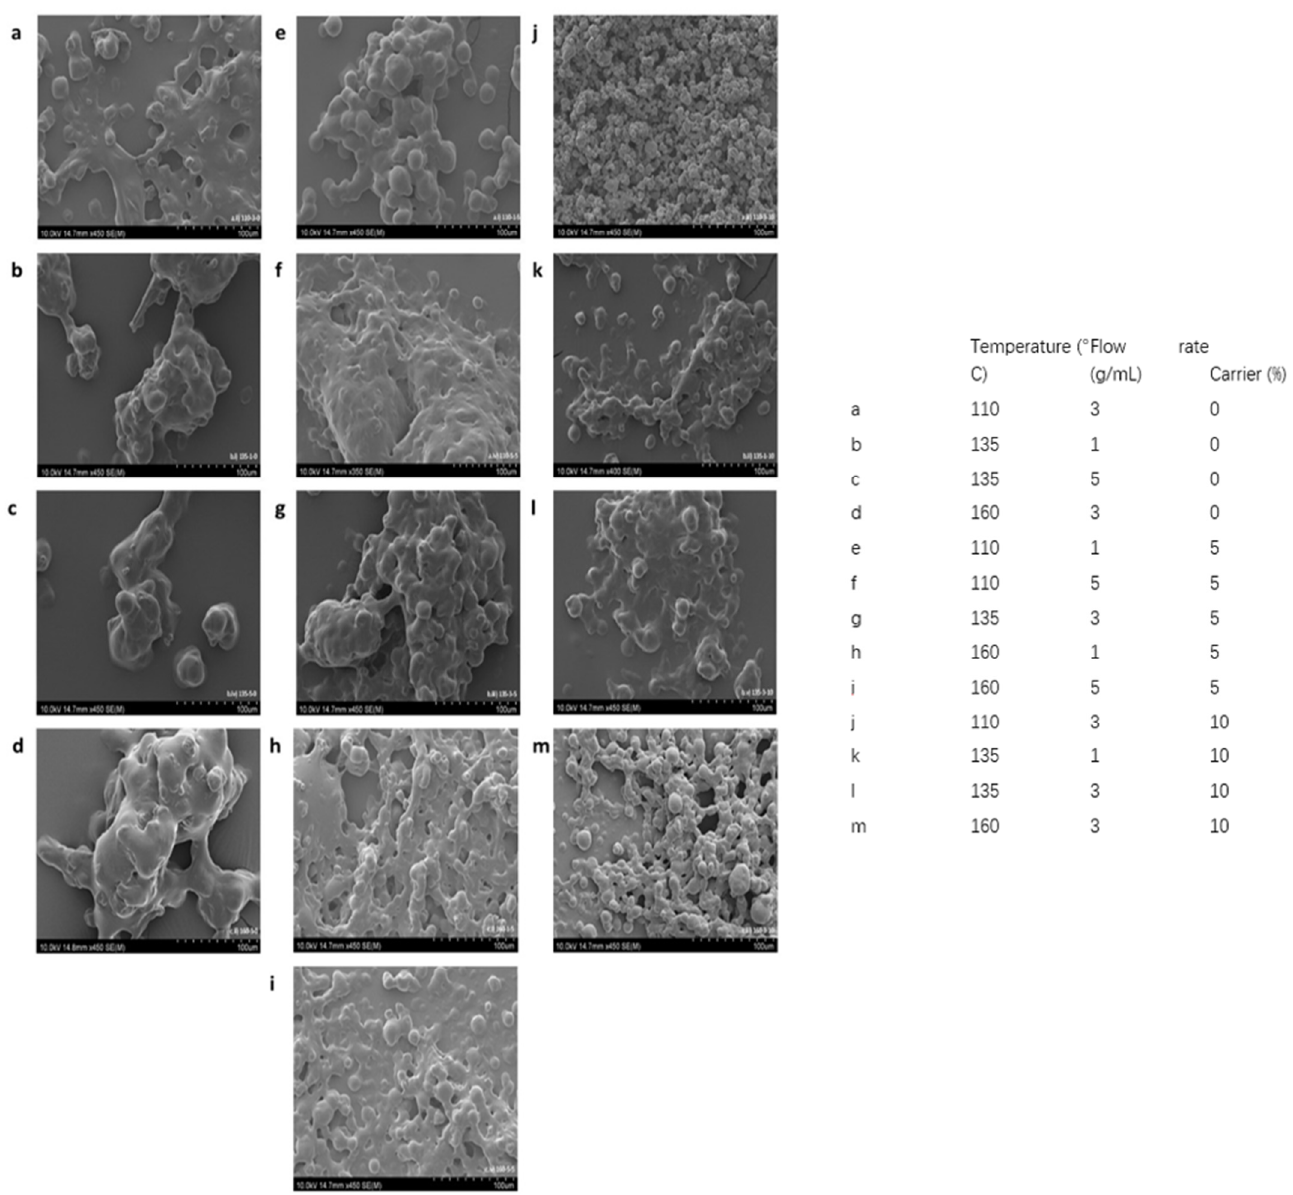
Figure 1. The microstructure of Tamarillo powder under different spray-drying conditions (temper- ature, flowrate, and carrier concentration). Powder microstructure shown in ( a – m ) varied with spray drying conditions summarised in the